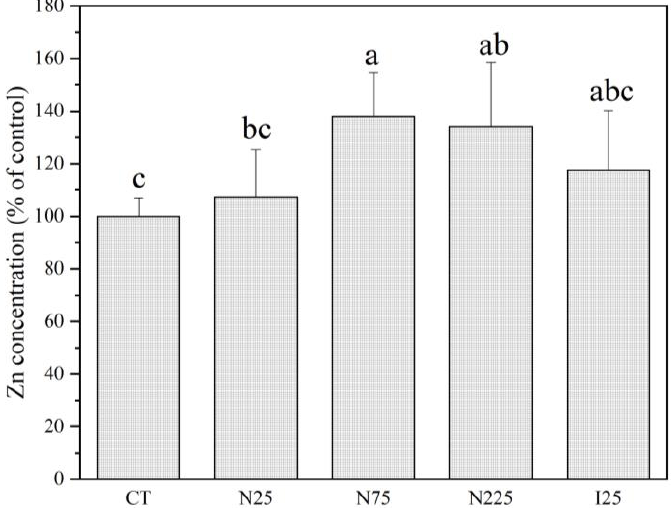
Figure 4. Contents of Zn in the corn kernels harvested from plants cultivated in CeO 2 NPs/CeCl 3 - amended soil. CT: control; N: CeO 2 NPs; I: CeCl 3 . Different letters stand for statistical differences between treatments at p ≤ 0.05.